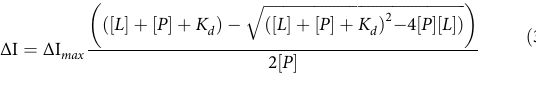
(Figs. 6e, f) 601 DNA, 5pmol 20-mer DNA (Figs. 7a), or 5 pmol 15-mer DNA (Supplementary Figure 11a) was incubated with increasing amounts of mutant or wild-type AF9-YEATS or Taf14-YEATS. In all, 1 pmol/lane (Figs. 5e-g and 6g and Supplementary Figure 10c) of nucleosome was incubated with increasing wild-type or mutant AF9-YEATS domain. The reaction mixtures were loaded on 5 – 10% native polyacrylamide gels and electrophoresis was performed in 0.2× TB or TBE buffer (1 ×TB/TBE = 90 mM Tris, 64.6 mM boric acid, with or without 2mM EDTA) at 100 – 130 V on ice. Gels were stained with ethidium bromide or SYBR Gold (Thermo Fisher) and visualized at 365 mm or by Blue LED (UltraThin LED Illuminator- GelCompany). Quanti fi cation of gel bands was performed using ImageJ. Each EMSA experiment was performed fi ve times (Figs. 5c, 6e), four times (Figs. 7a, f and Supplementary Figure 11a), three times (Fig. 5e), twice (Fig. 5f and Supplementary Figure 10c), and once (Figs. 5g and 6f,